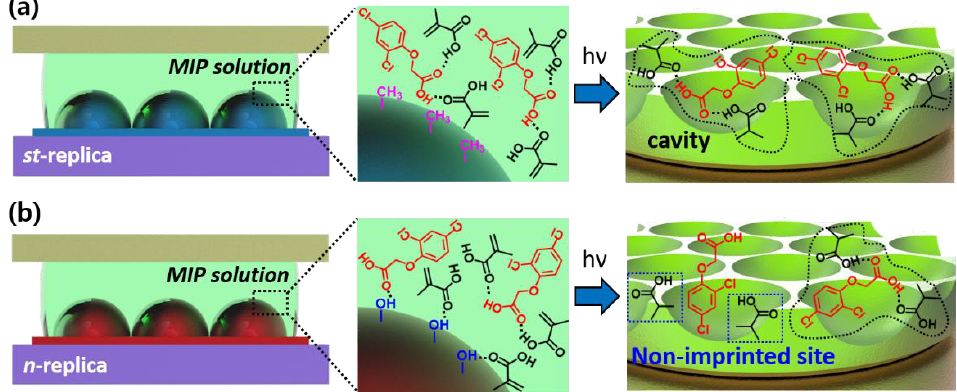
Figure 5. Expected molecular imprinting recognition on porous MIP films, obtained from surface imprinting using two replica molds: ( a ) st -replica mold and ( b ) n -replica mold.